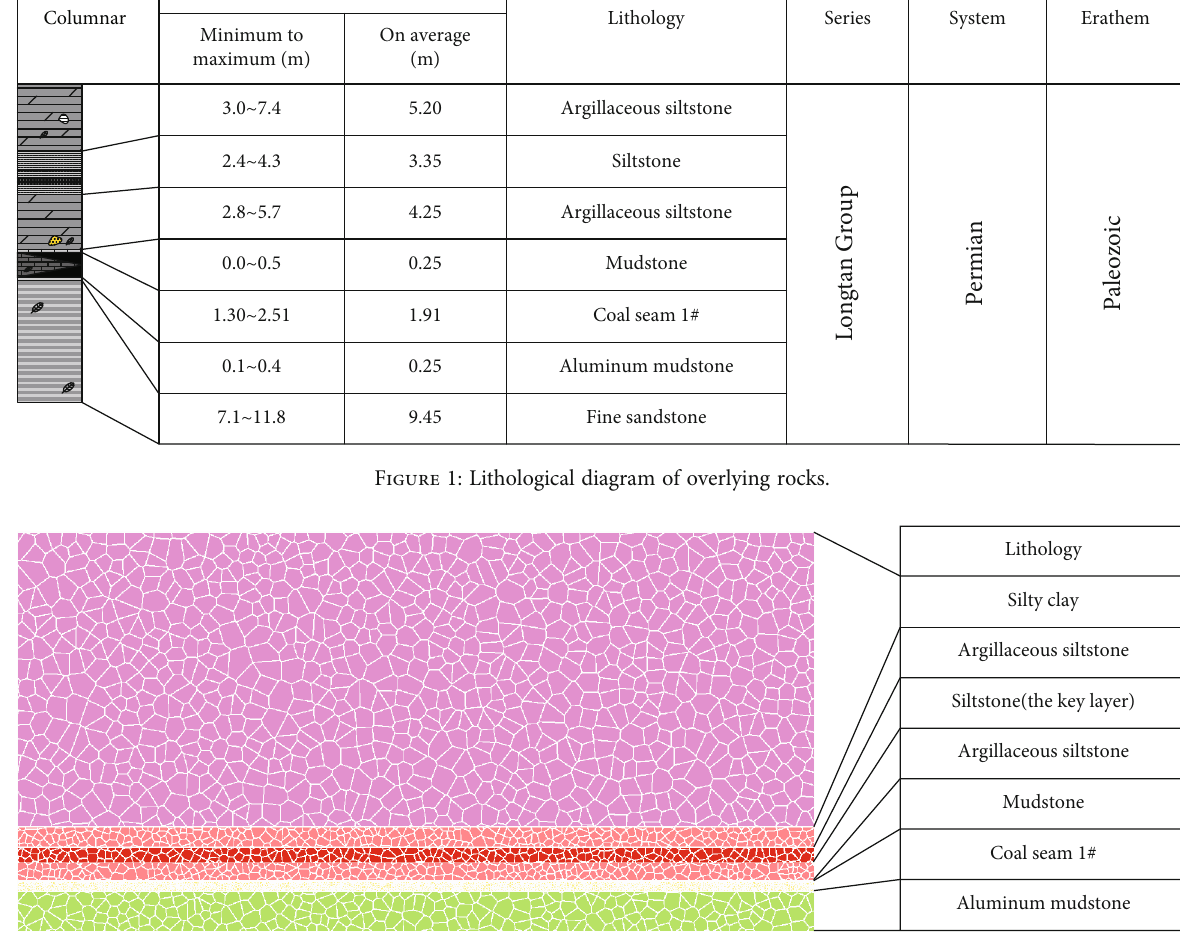
Figure 2: Sketch of the numerical model. Table 1: Physical and mechanical parameters of coal